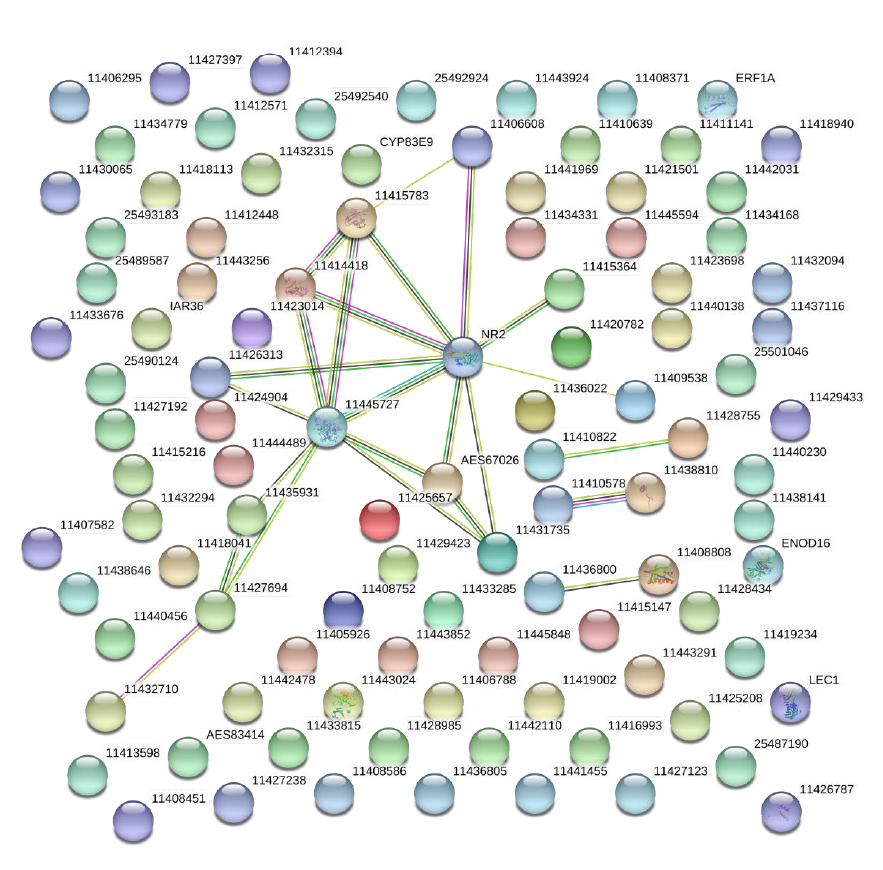
Figure 6. The proteins connected to nitrate reductase (NR2) according to their codes in the STRING database are (beginning from the upper part of the network and moving counterclockwise)